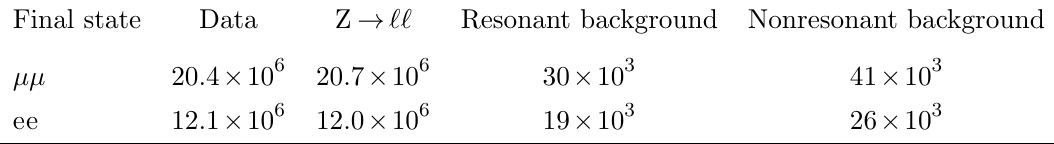
Table 1 . Summary of data, expected signal, and background yields after the full selection. The predicted signal yields are quoted using MadGraph 5 a mc@nlo . The statistical uncertainties in the simulated samples are below